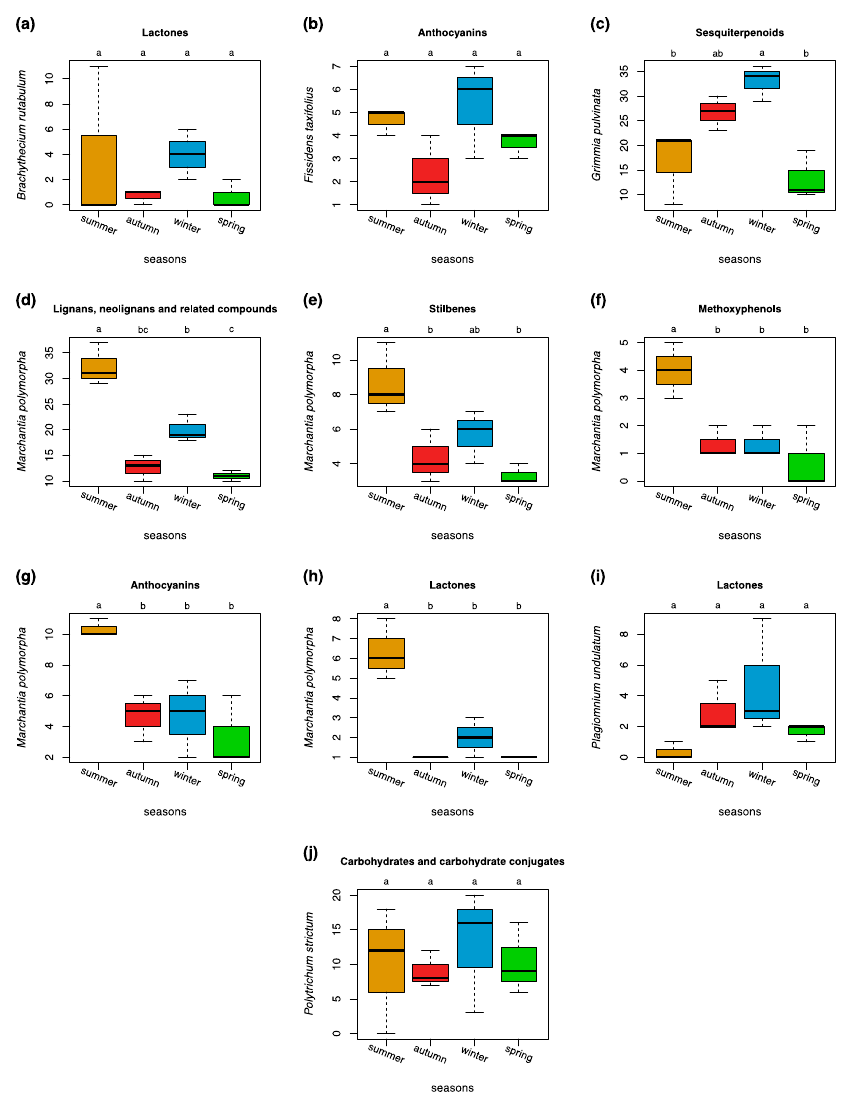
Figure 6. Seasonal variations in selected compound classes of selected species. ( a ) Lactones in B. rutabulum , ( b ) anthocyanins in F. taxifolius , ( c ) sesquiterpenoids in G. pulvinata , ( d ) lignans, neolignans, and related conjugates in M. polymorpha , ( e ) stilbenes in M. polymorpha , ( f ) methoxyphenols in M. polymorpha , ( g ) anthocyanins in M. polymorpha , ( h ) lactones in M. polymorpha , ( i ) lactones in P. undulatum , and ( j ) carbohydrate and carbohydrate conjugates in P. strictum . Differences among groups (letters on the top of the plot) are based on the Tukey HSD post hoc test on a one-way ANOVA. Different letters show significant differences ( p < 0.05). n = 27 for each season.